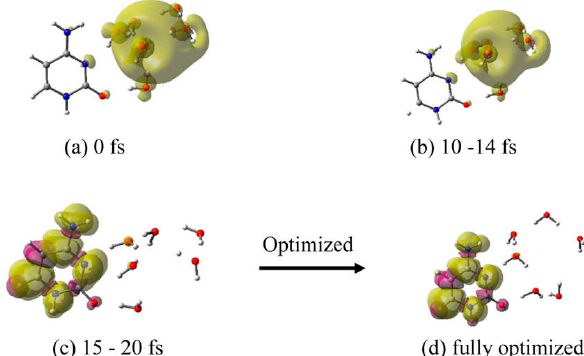
Figure 5. Total spin density plot of C-6H 2 O • − at different times during MD simulation: ( a ) 0 fs (initial optimized starting structure for simulation), ( b ) 10 − 14 fs, ( c ) 15 − 20 fs, and ( d ) fully optimized structure. Structure d is stabilized by − 0.64 eV over structure a . Reprinted with permission from reference [72]. Copyright, 2016, American Chemical Society.